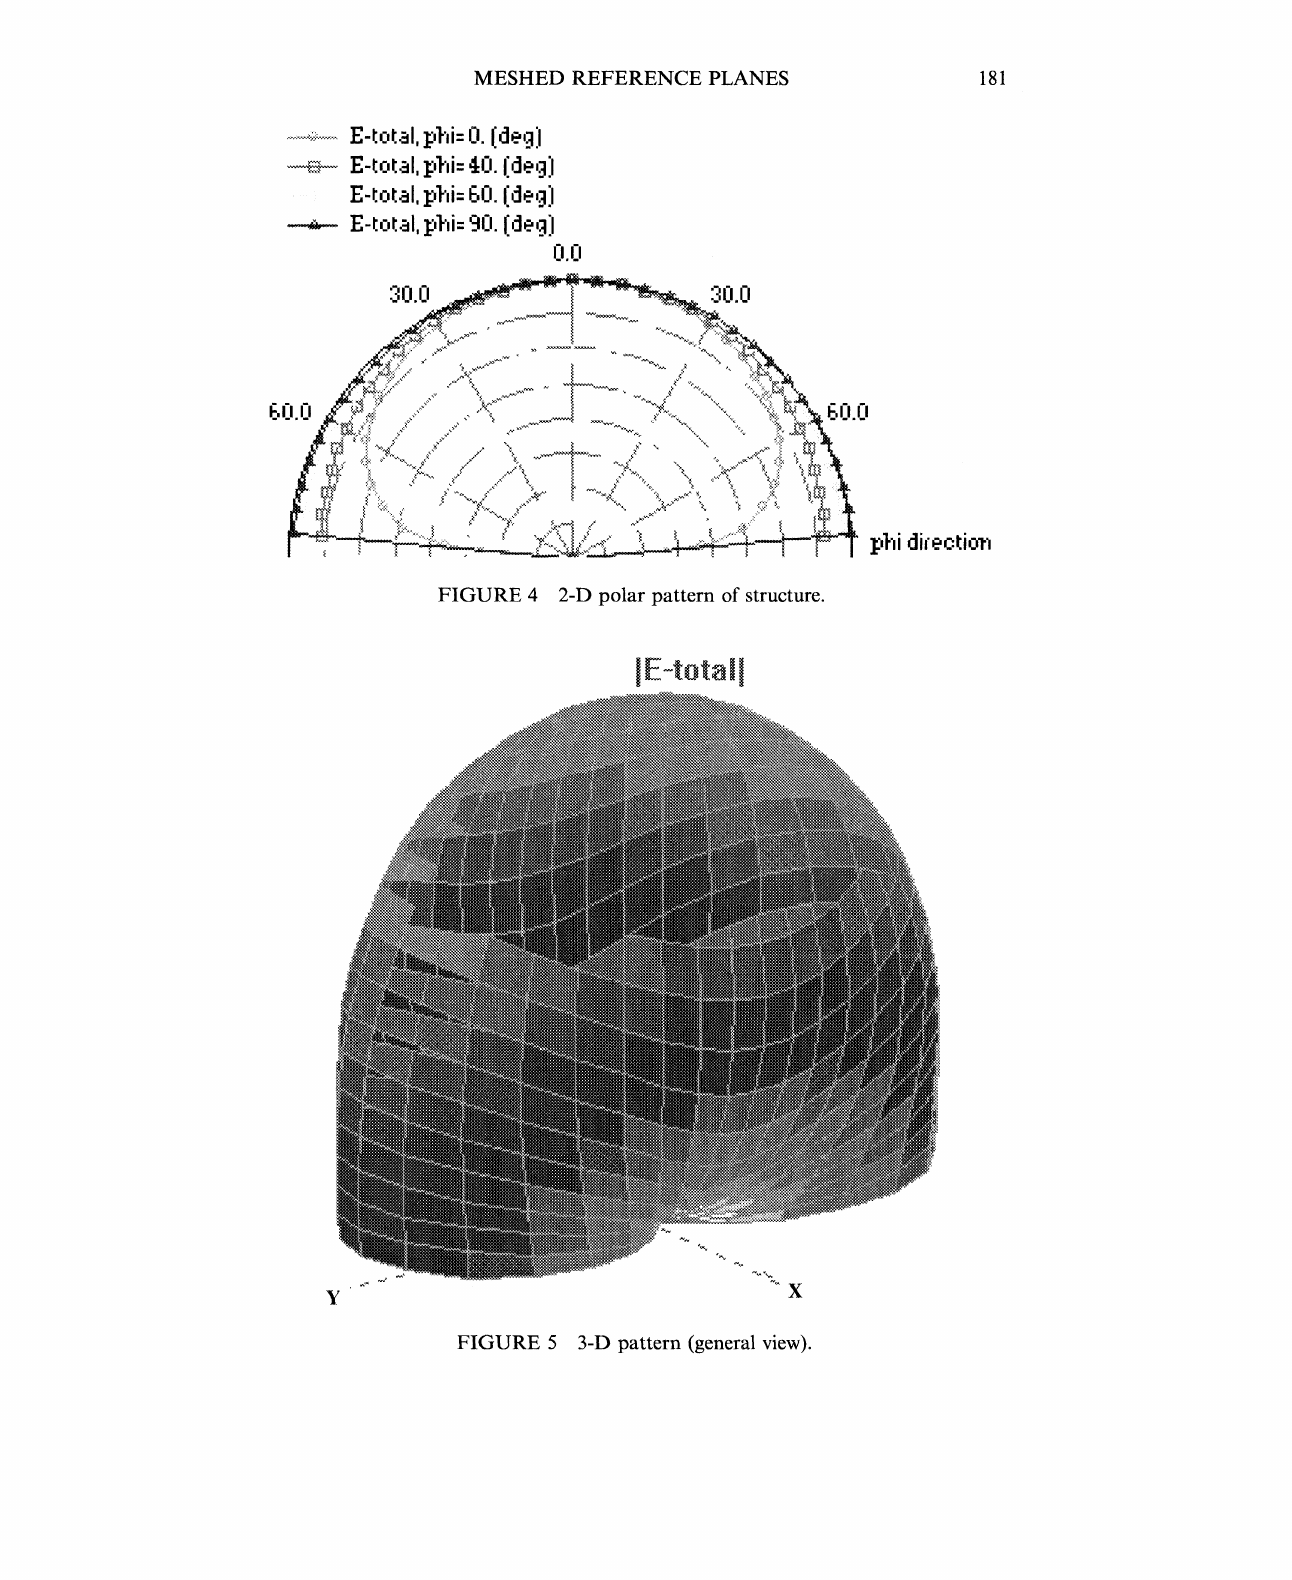
FIGURE 5 3-D pattern (general